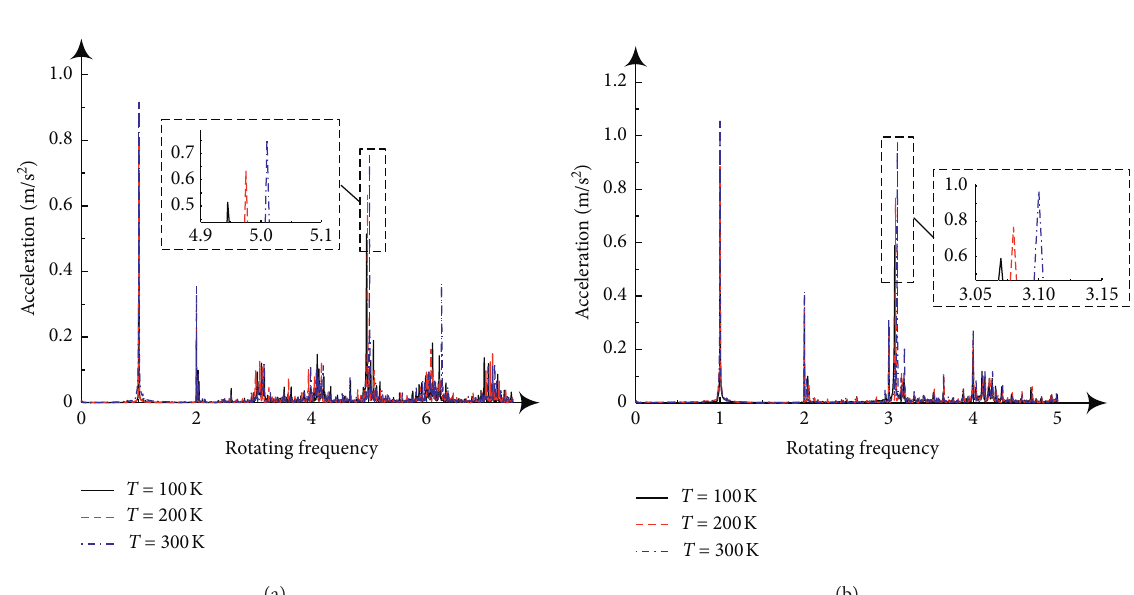
Figure 11: Vertical accelerations at different temperatures with different defects. (a) Inner raceway defect. (b) Outer raceway